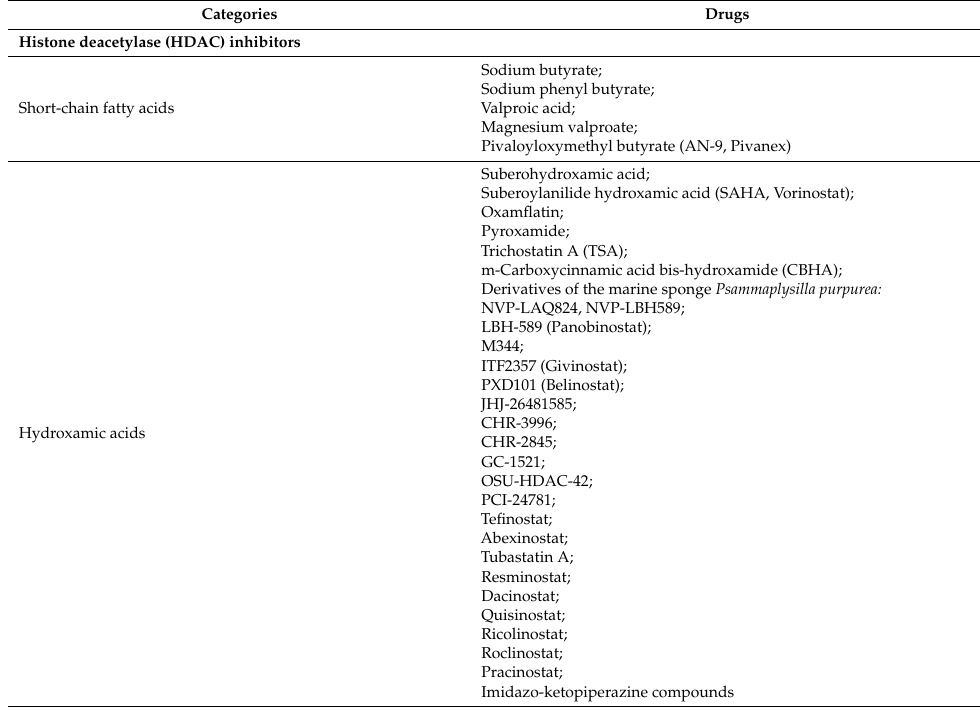
Table 3. Classification of histone deacetylase inhibitors and related